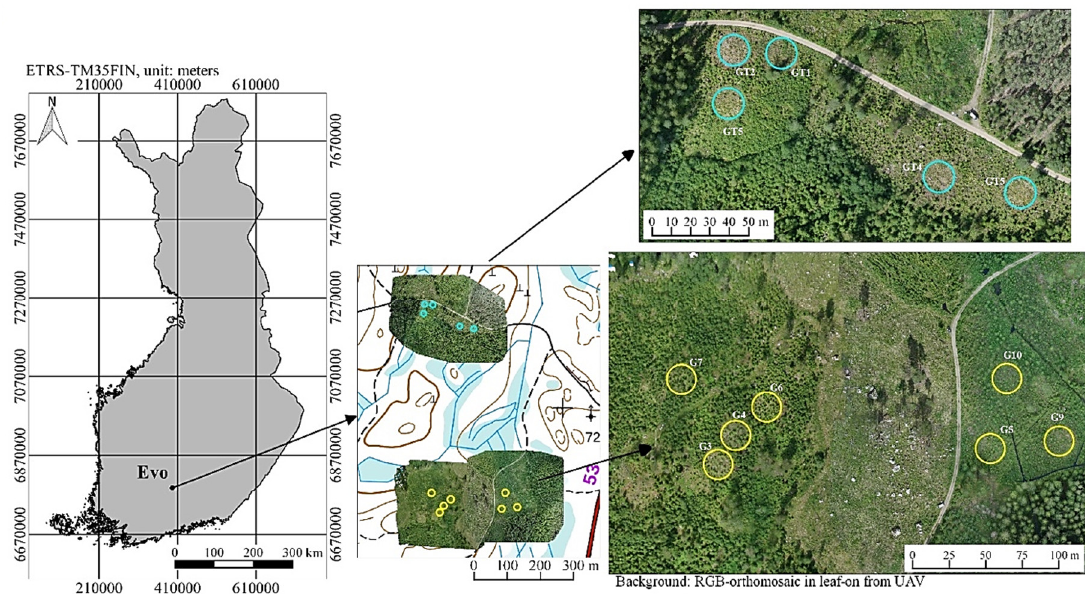
Figure 1. Map of the study area and established sample plots in young seedling stand (upper image block) and in advanced seedling stand (lower image block).